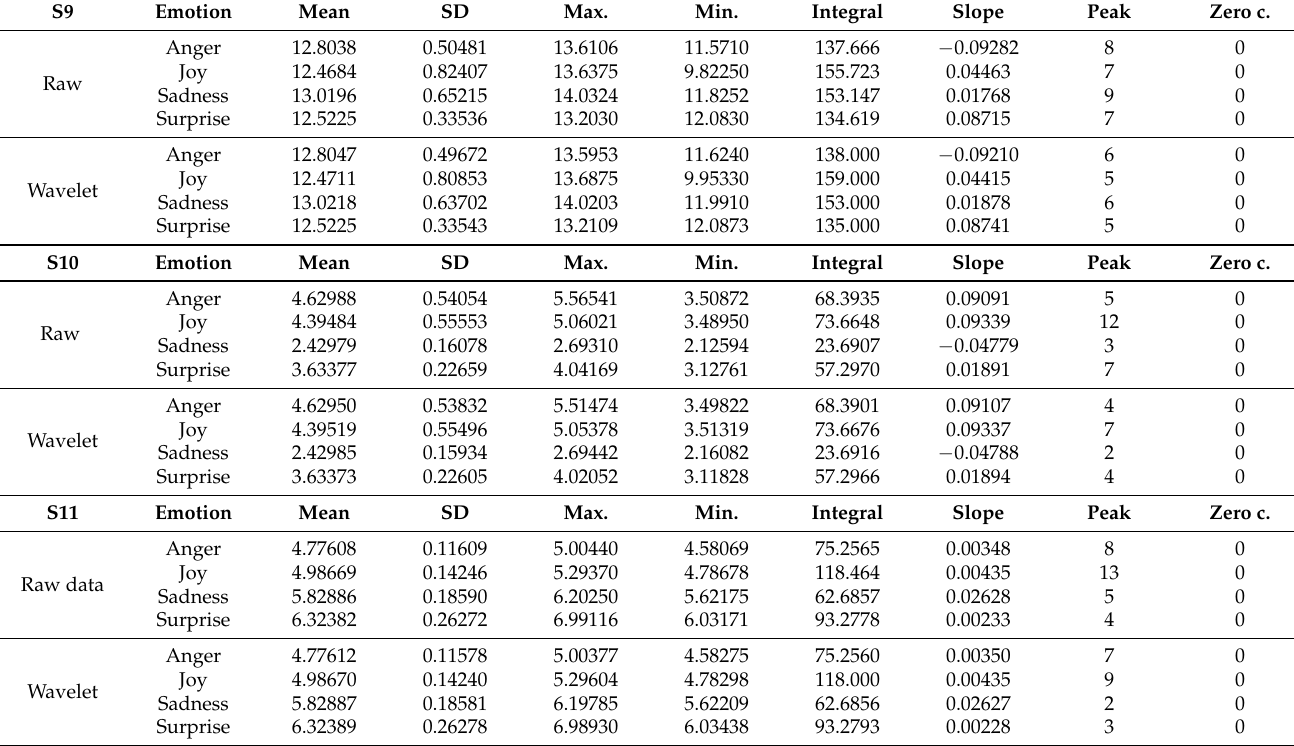
Table 2. Features in EDA data of all subjects